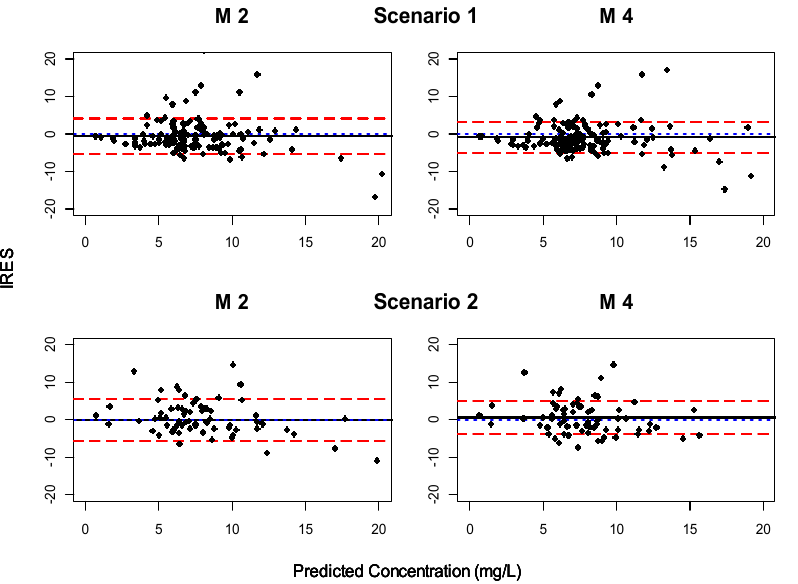
Figure 3. Individual residual (IRES) versus the individual predicted concentrations for M2 and M4 in Scenario 1 and Scenario 2. The mean IRES (black solid line) represents the bias of each model; red dashed line, 5th and 95th percentile for IRES; blue dotted line to highlight the line corresponding to 0. The M numbers represent the models described in Table 1.